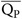
Block diagram of the PID controller for closed loop studies.CVS, cardiovascular system; LVAD, left ventricular assist device; PWM, pulse width modulation; PID, Proportional-integral-derivative controller; QP, instantaneous pump flow; QP-, mean pump flow; QPm-, measured mean pump flow; PLVEDm, measured left ventricular end diastolic pressure; PIQPm, measured pump flow pulsatility; HCVS, differential pressure between the left ventricle and the aorta. PLVEDm serves as the input to the preload controller (1), while both PIQPm and QPm- are inputs to the pulsatility controller (2).